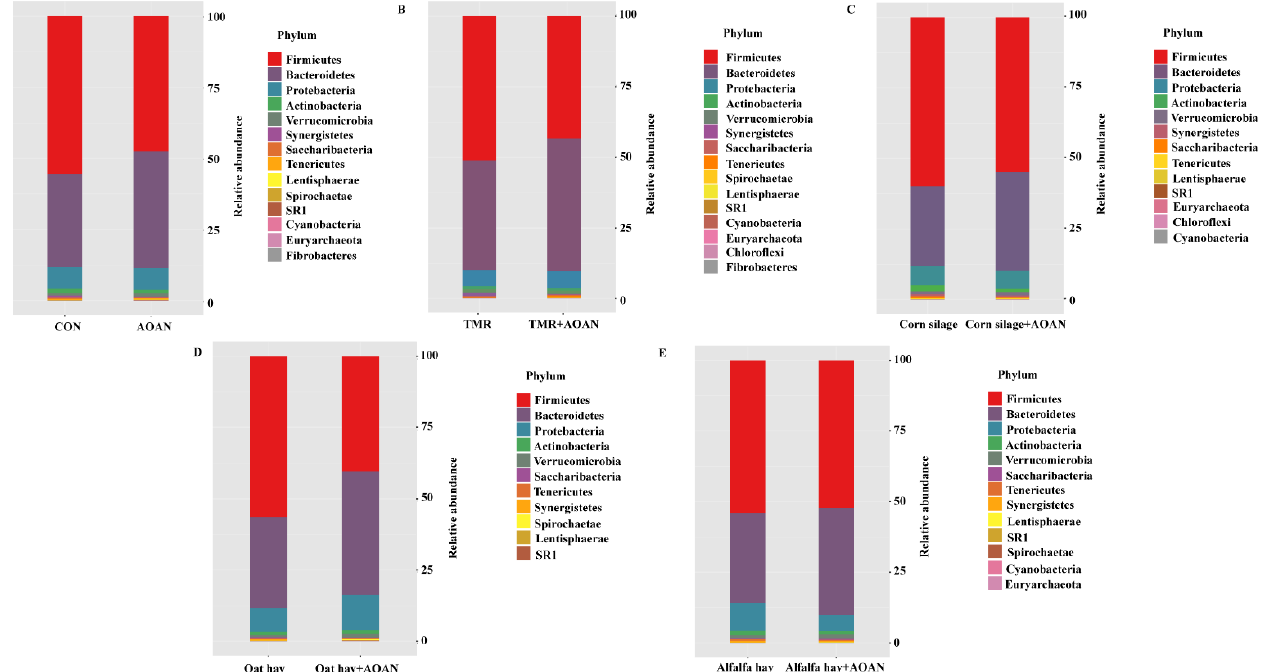
Figure 7. Effects of Aspergillus oryzae and Aspergillus niger co-cultivation fermentation extract on the composition of phyla of bacterial communities in a TMR ( B ), corn silage ( C ), oat hay ( D ), alfalfa hay ( E ), and all ( A ). AOAN indicates fermentation with Aspergillus oryzae and Aspergillus niger co-cultivation fermentation extract. CON group indicates all feeds without AOAN supplementation. AOAN group indicates all feeds with AOAN supplementation. TMR, total mixed ration.